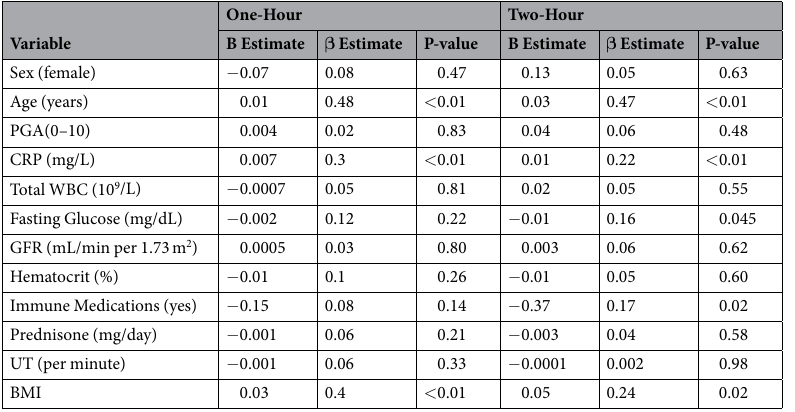
Table 3. Clinical Factors Associated with Arterial FDG Uptake at One and Two-Hour Imaging Time Points. BMI, Body Mass Index; CRP, C-Reactive Protein; GFR, Glomerular Filtration Rate; Immune Medications (yes), taking immunosuppressant medications other than glucocorticoids; PGA, Physician Global Assessment; Total WBC, Total White Blood Cell Count. Normalized Beta Estimates ( β Estimate) given as absolute values; Beta Estimates (B